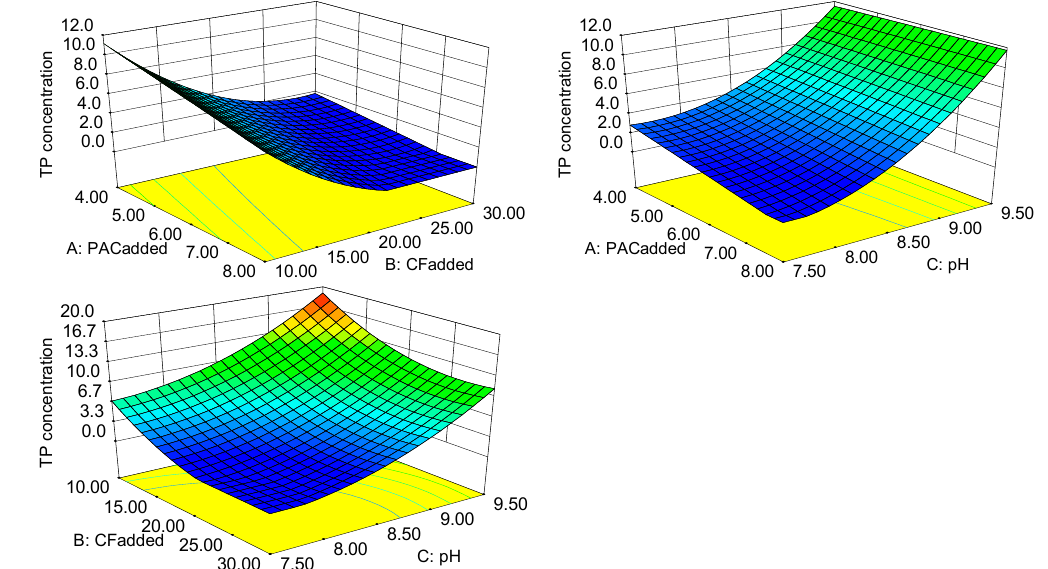
Figure 3. Response surface of the TP concentration.